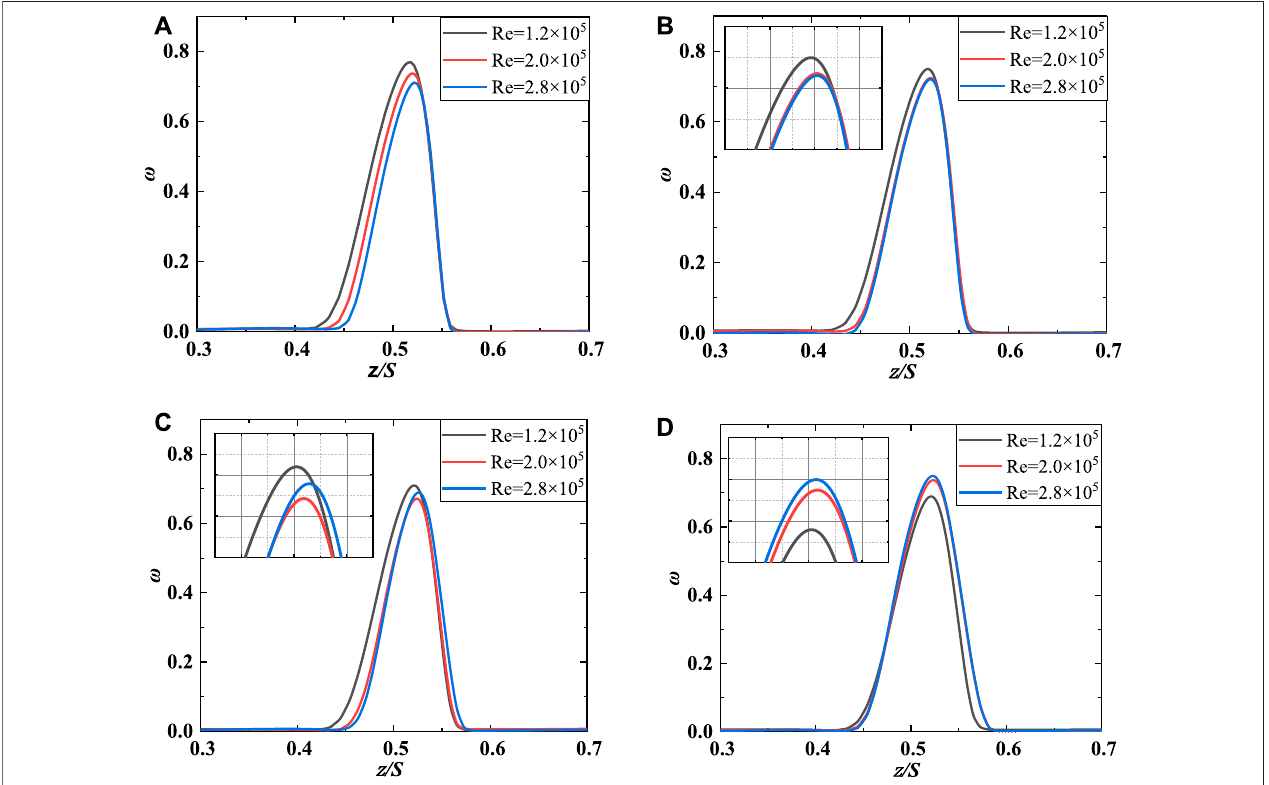
FIGURE 12 | Effects of roughness on cascade wake loss at different Reynolds numbers: (A) smooth, (B) 19 μ m, (C) 74 μ m, and (D) 180 μ m.